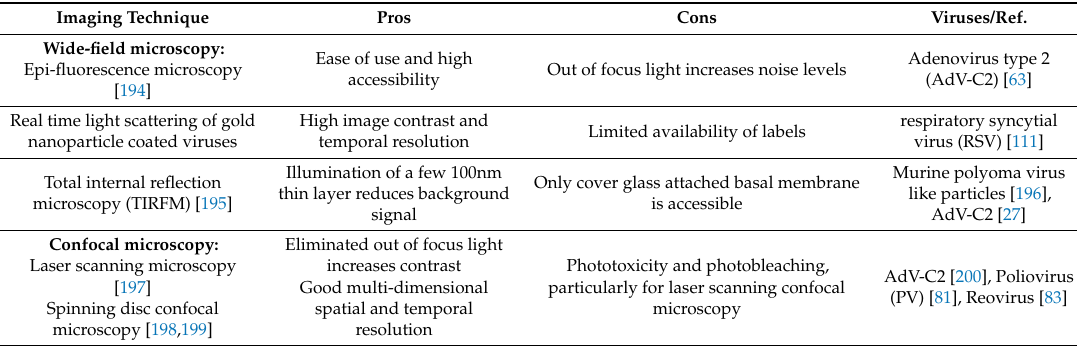
Table 2. Techniques for live cell visualization of viruses and pros and cons in virus tracking experiments. Additional examples of techniques used for virion imaging are listed in Table